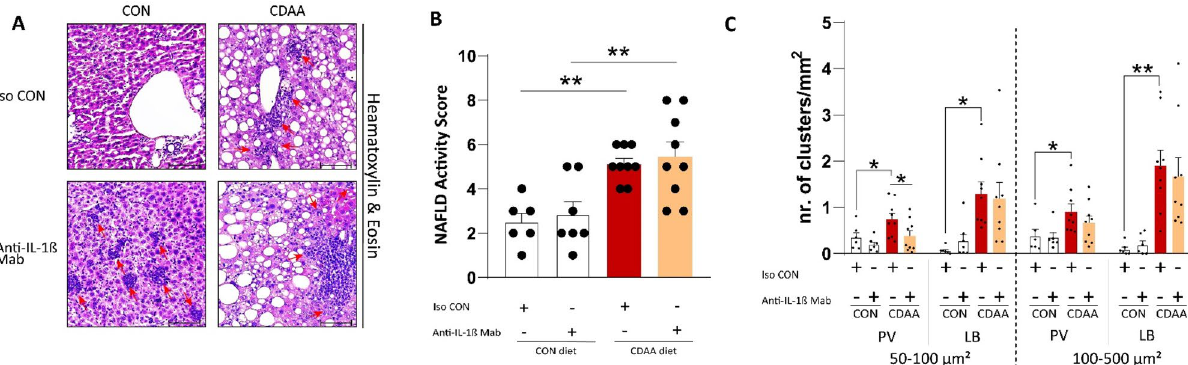
Figure 3. Histological assessment of inflammatory cell infiltrations. Investigation of hepatic inflammatory foci (red arrows) on hematoxylin–eosin stained sections ( A ). NAFLD Activity Score (NAS) ( B ). Evaluation of number, area and anatomical site of the immune cell infiltrations ( C ) (n = 6–9/group). CDAA, Choline Deficient L-Amino Acid-defined diet; CON, control diet; Iso CON, isotype control; Anti-IL-1β, anti-interleukin-1β monoclonal antibody; PV, periportal; LB, lobular. Scale bar shows 100 µm. Two-way ANOVA, Fisher’s LSD post hoc test, * P < 0.05, ** P < 0.01, *** P <